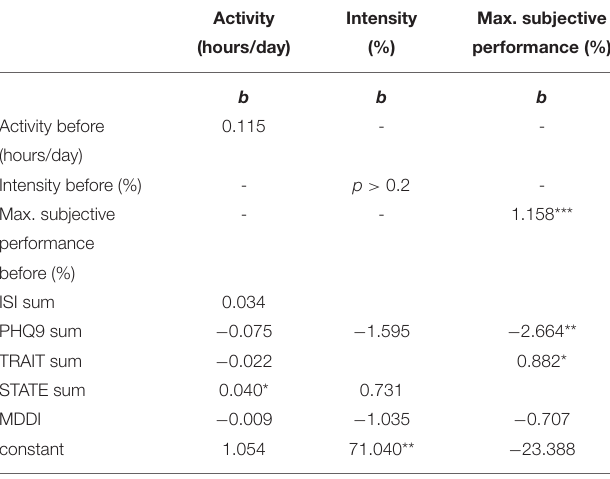
TABLE 4 | Multivariate regression of activity, intensity and maximal subjective performance during